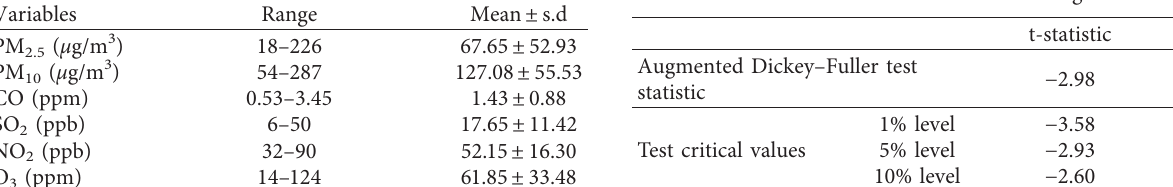
Table 2: The ADF test of the training data.